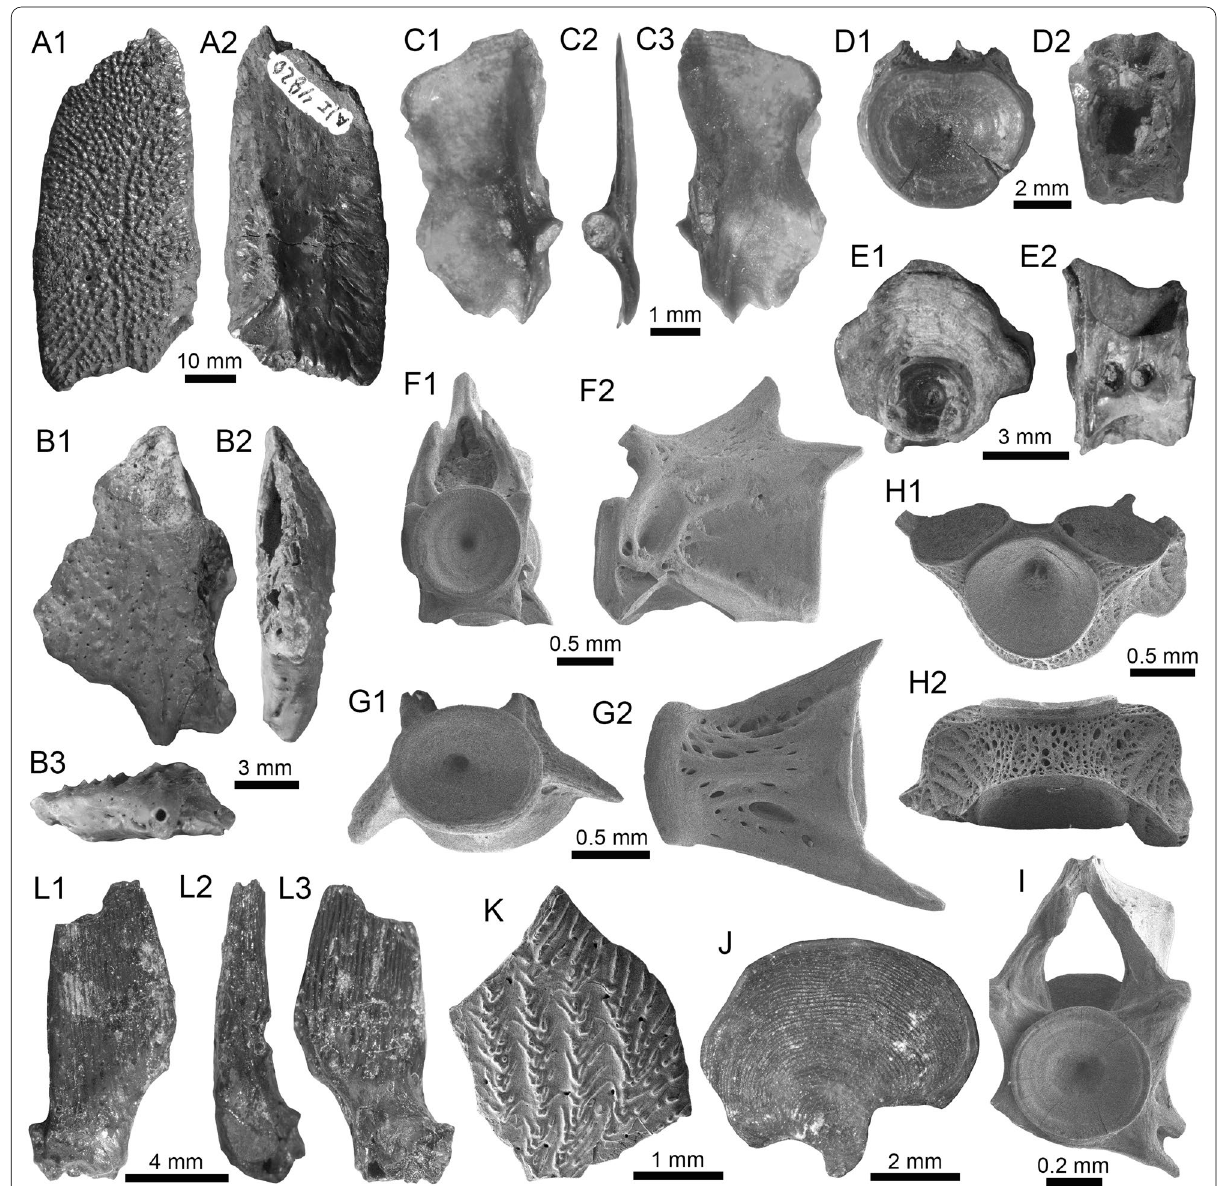
Fig. 7 Indeterminate actinopterygians from the Iquitos assemblage. A1 – B3 Dermal cranial bones ( A1 – A2 : PIMUZ A/I 4820; B1 – B3 : PIMUZ A/I 5018). C1 – C3 Operculum (PIMUZ A/I 4977). D1 – I Vertebrae ( D1 – I : PIMUZ A/I 4989; E1 – I : PIMUZ A/I 4966). J – K Scales ( J : PIMUZ A/I 5055). L1 – L3 fin‑spine (PIMUZ A/I 5012). Views: anterior ( C2 , D1 , E1 , F1 , G1 , H1 , I ), dorsal ( A1 , B1 ), external surface ( J , K ), internal surface ( A2 , C1 ), lateral ( C3 , B2 ), left lateral ( E2 , F2 ), right lateral ( D2 ), posterior (? B3 ), ventral ( G2 , H2 ), and indet. ( L1 – L3